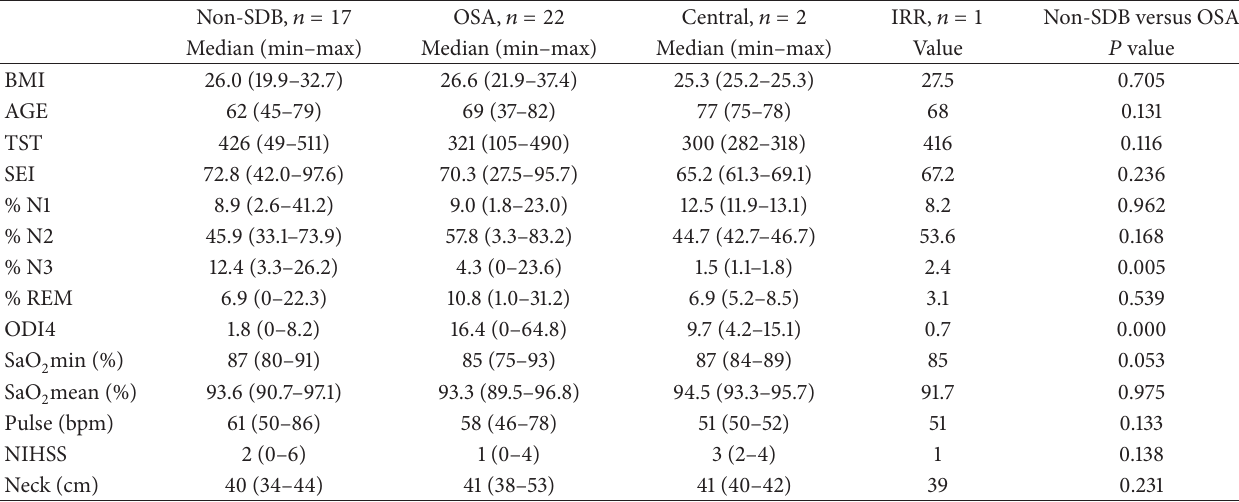
Table 4: Some demographic and sleep parameters of the different subject